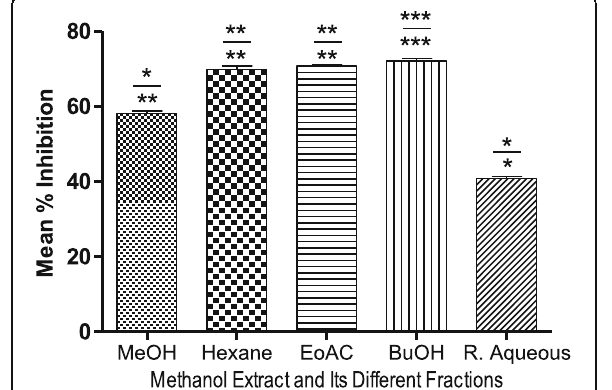
Fig. 4 Effect of TPC and TFC on α -Glucosidase Inhibitory Activity. Bars with *** P < 0.01, ** P < 0.01, * P < 0.05 are Significantly Correlated whereas ns P > 0.05 Denotes Non significant Correlation According to Bonferroni Posttests (The Numerator on Bar Represent the Correlation with TPC and Denominator with